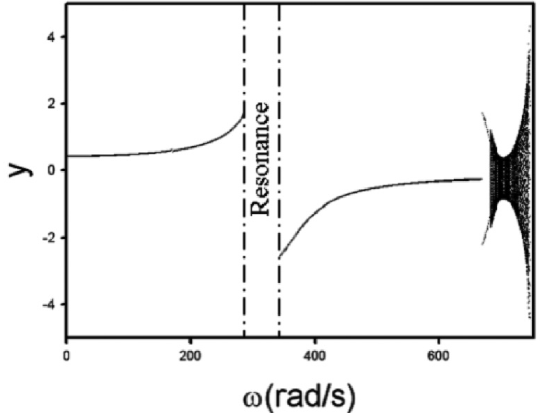
Fig. 6. The bifurcation diagram of y -displacement at the mid-span point versus rotation speed excited by oil- fi lm force. D = 0.25 m, γ m = 1000 T 2 m/H, ρ s = 7800 kg/m 3 , E = 206 GPa, C = 0.001 D , C e = D /1600, L = 3 m, L b = D /4, e ¯ m = 0 . 0001 m, x a = 0.08, x b = 0.92, μ o = 0.001 Pa · s.